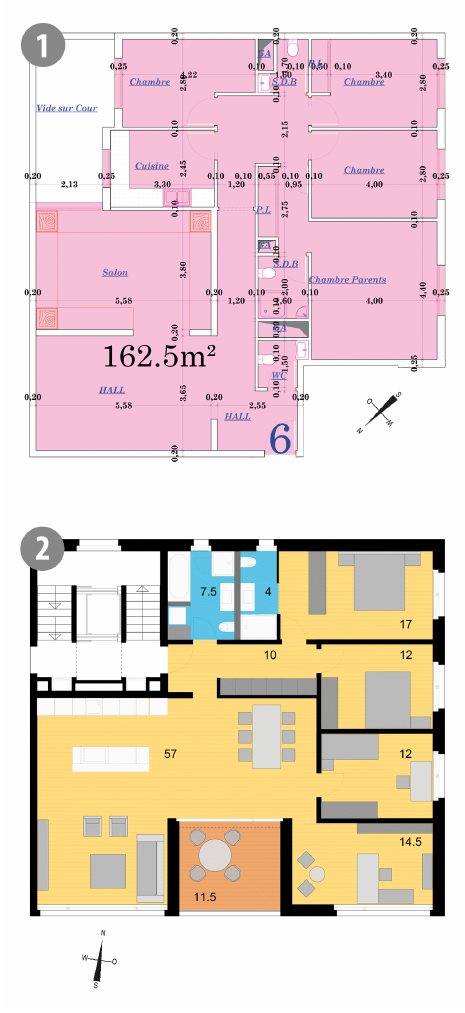
Figure 2. Two examples of openly accessible floorplans used as training data in our experiments. Different geographic regions (1:Morocco, 2: Germany/ Switzerland), different floorplans and room shapes (e.g. L and I) are